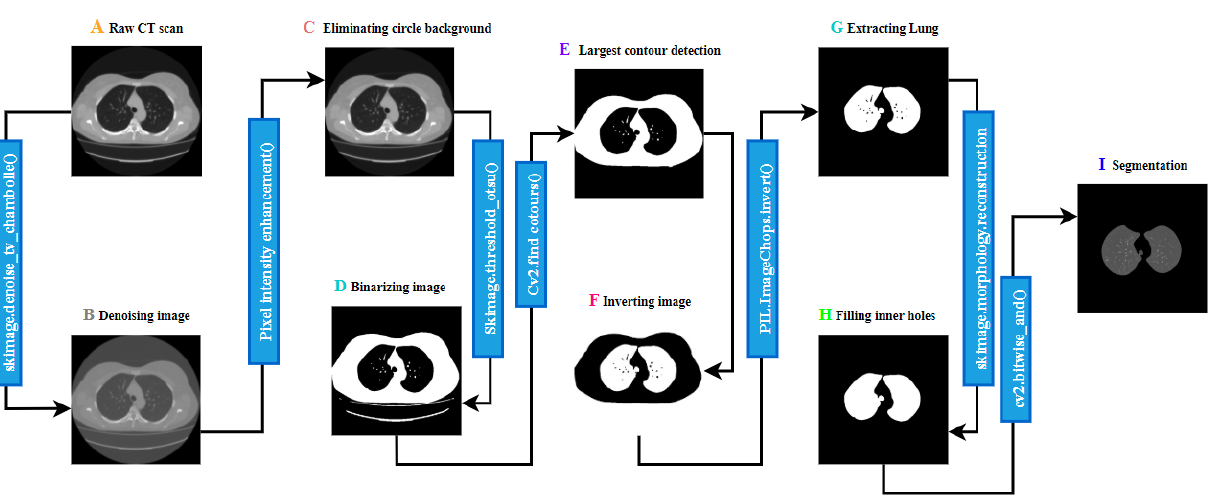
Figure 9. Lung segmentation process.